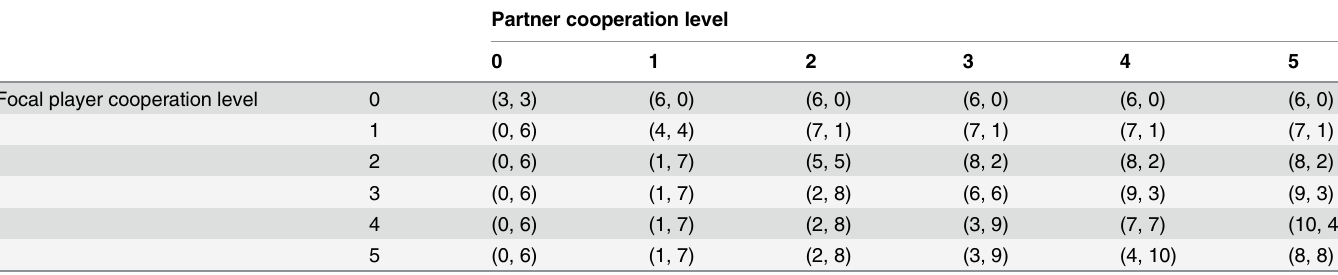
Table 1. Payoffs accrued by player and partner for each decision combination in step